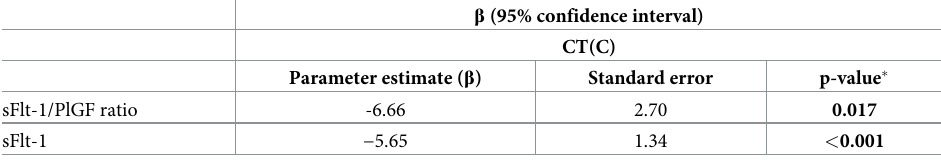
Table 4. Choroidal thickness associated with sFLT-1/PlGF ratio and